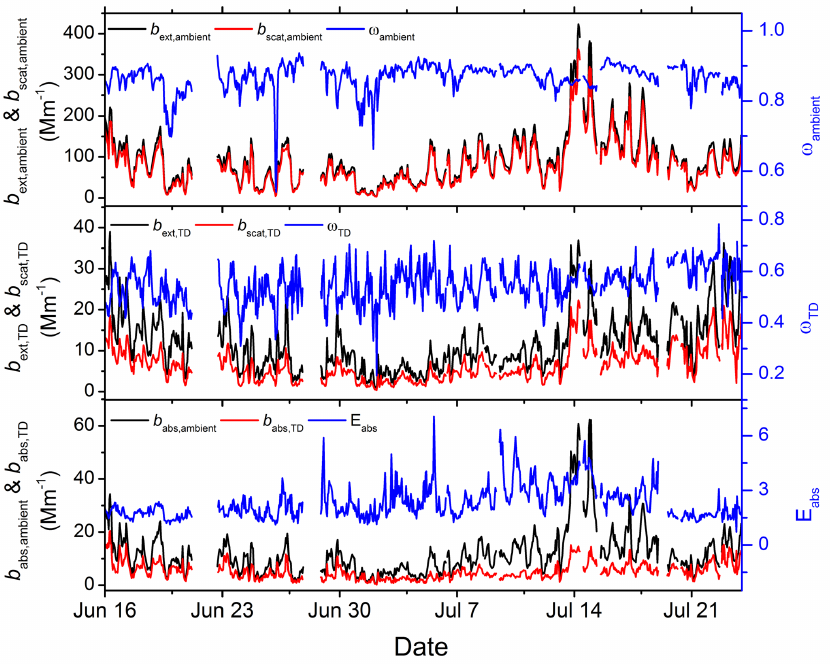
Figure 4. Time series of the optical parameters and absorption enhancement ( E abs ) at λ = 532nm at a time resolution of 10min. Properties shown are the extinction ( b ext ), scattering ( b scat ), and absorption coefficients ( b abs ), the SSA ( ω ) of ambient particles ( b ambient ), and particles passed though the thermodenuder ( b TD ) at 300 ◦ C (after correcting for particle